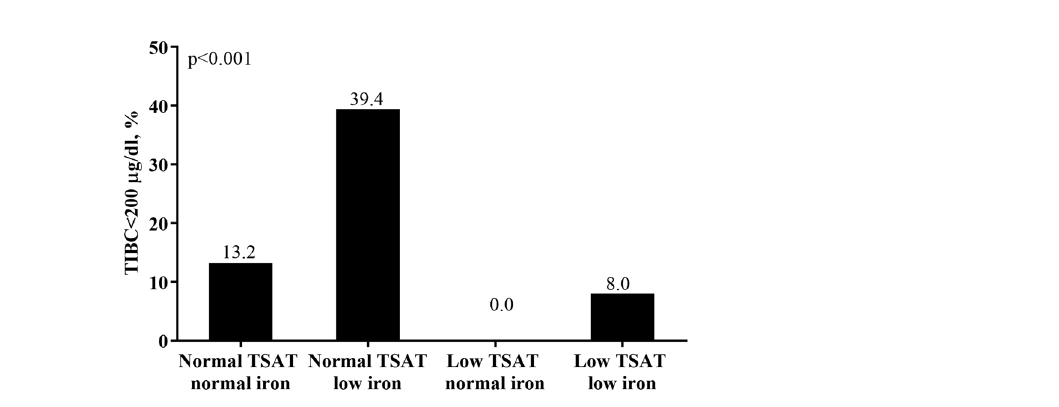
Figure 2. Low TIBC devided by TSAT and serum iron.